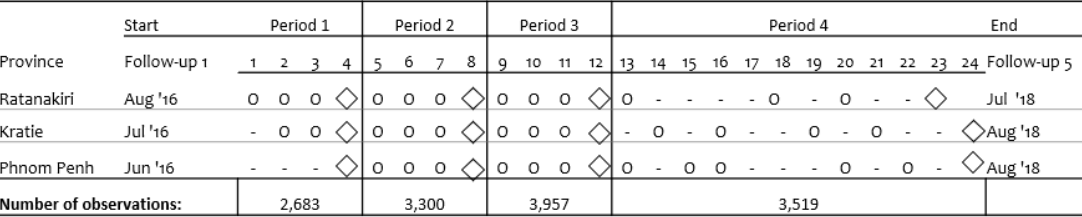
Figure 1. Timeline of the study represented by the period between follow-ups and including the sample size available for each period. ◊ Follow-up visit; o Morbidity monitoring visit; Number of observations: Observations that have both anthropometric and morbidity